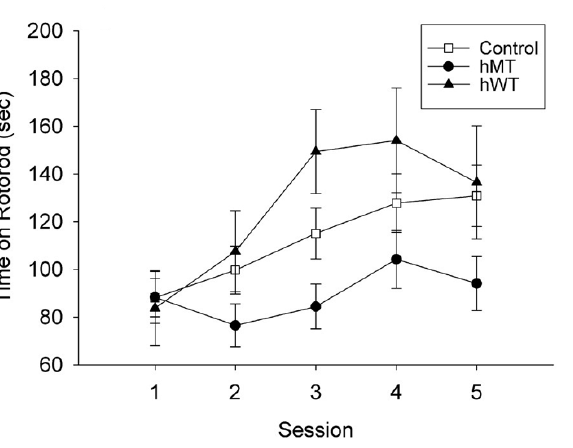
Figure 1. Effect of the overexpression of human wild-type (hWT) and mutated (hMT) torsinA on locomotor activity with respect to non-transgenic littermates (control). The transgene-positive hMT mice fell off the rotarod sooner than the hWT mice ( p < 0.05). Reproduced with permission from [57].